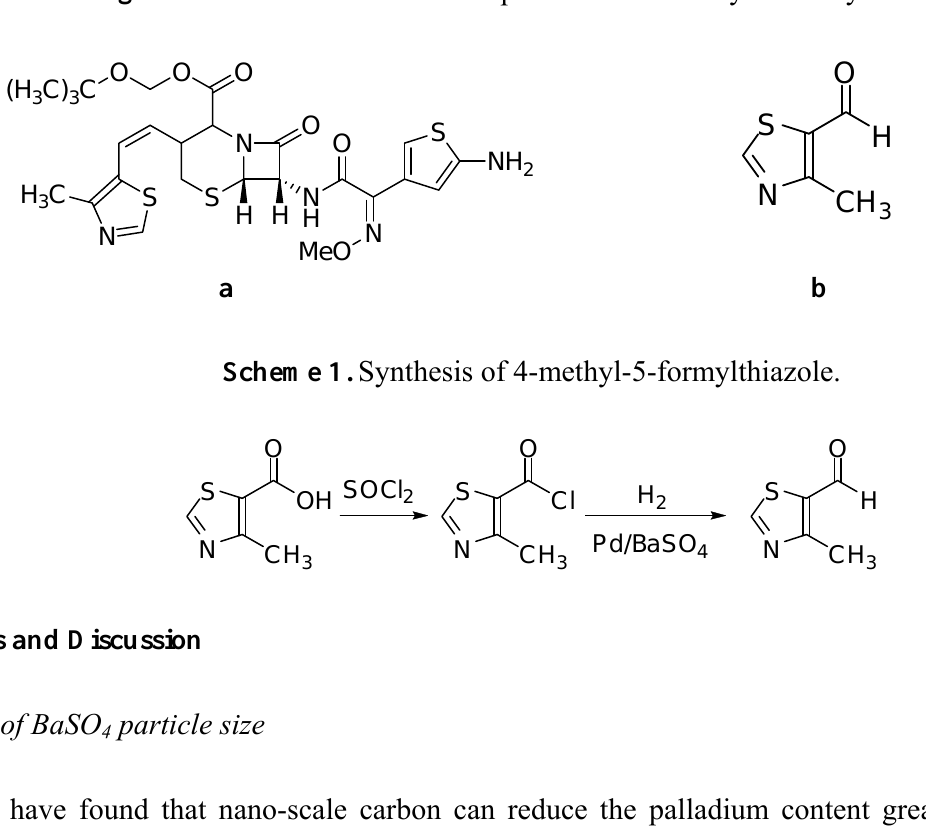
Figure 1. Structure of cefditoren pivoxil and 4-methyl-5-formylthiazole.